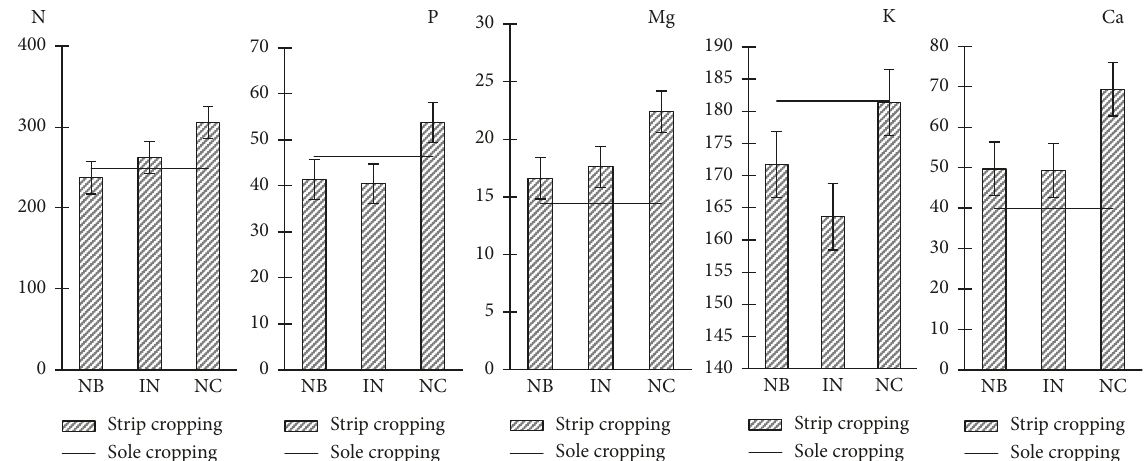
Figure 2: The influence of cropping method and row position in the strip on macronutrients uptake by maize biomass (in kg · ha − 1 ) (mean for 2008–2010). NB, row next to barley; IN, inner row; NC, row next to common bean.